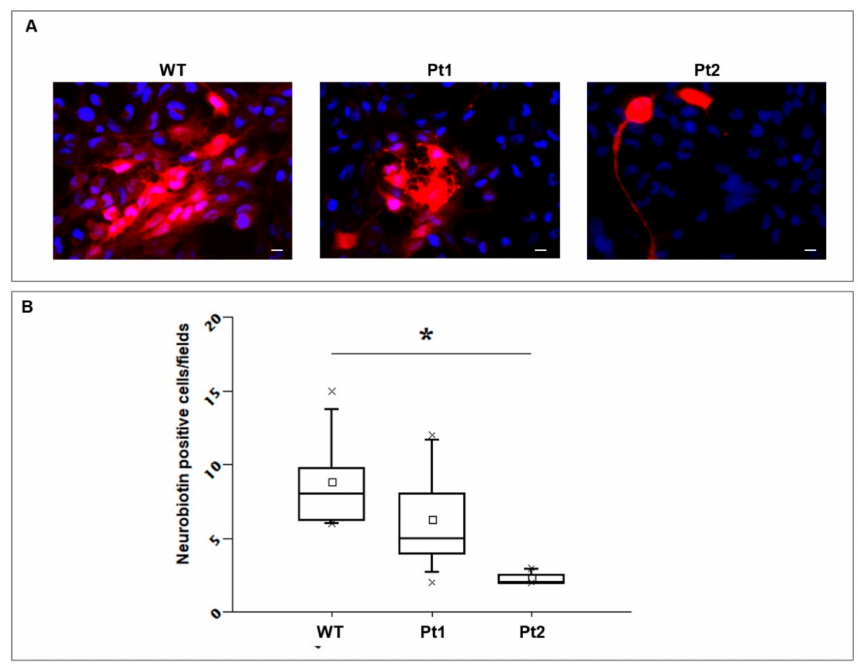
Figure 8. Evaluation of gap-junction permeability by the neurobiotin di ff usion assay: The whole-cell configuration of the patch-clamp technique was used to inject the gap-junction permeable agent neurobiotin in single U251 astrocytoma cells in order to evaluate its di ff erential di ff usion in cell lines overexpressing MLC1 WT or carrying Pt1 or Pt2 pathological mutations. ( A ) After 10 min of neurobiotin injection, fixation, and incubation in streptavidin-TRIC / DAPI, fluorescence images were taken for further analysis. Exemplifying images of merged streptavidin-TRIC and DAPI fluorescence channels (red for neurobiotin and blue for DAPI) are shown in the panels. The number of neurobiotin-di ff used cells is higher in WT MLC1 cells compared to cells expressing Pt1 and Pt2 pathological mutations, with the latter showing the lowest number of neurobiotin-positive cells. ( B ) The number of neurobiotin-positive cells in the U251 lines expressing MLC1 WT or carrying Pt1 or Pt2 pathological mutations were pooled and distributed as a boxplot. ANOVA analysis was used for testing statistical significance. The three groups were shown to be statistically di ff erent ( n = 3–7; * p < 0.05), with MLC1 WT cells reporting the highest number and Pt2 cells reporting the lowest number of neurobiotin-di ff used